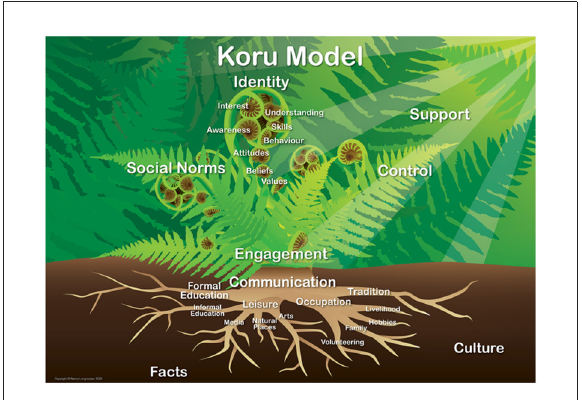
FIGURE1 The Koru Model of science communication [adapted from Longnecker (2016)]. Individual learners (symbolized by a koru or unfurling fern frond) obtain information from a wide range of communication avenues (roots in this visual metaphor). Learners are more likely to engage with information when it is relevant to them and aligns with their self-perceived identity. Whether and how learners make use of new knowledge is impacted by external factors, including perceived social norms, support, and control. Individual learners use new information to confirm existing schema or to construct new knowledge. The koru is a New Zealand M¯aori symbol for growth and new beginnings and is used as a sign of respect for m¯atauranga M¯aori/ M¯aori knowledge, culture and